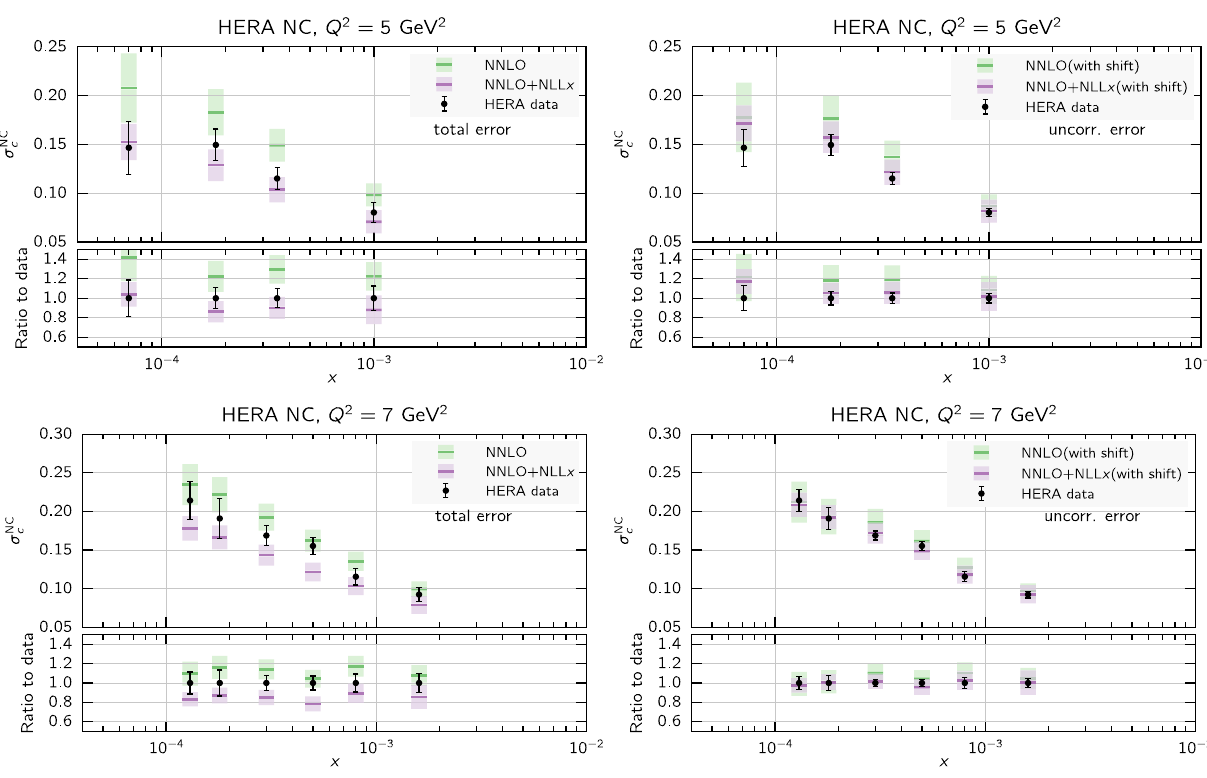
Fig. 22 Same as Fig. 20 for the HERA charm-production cross-sections